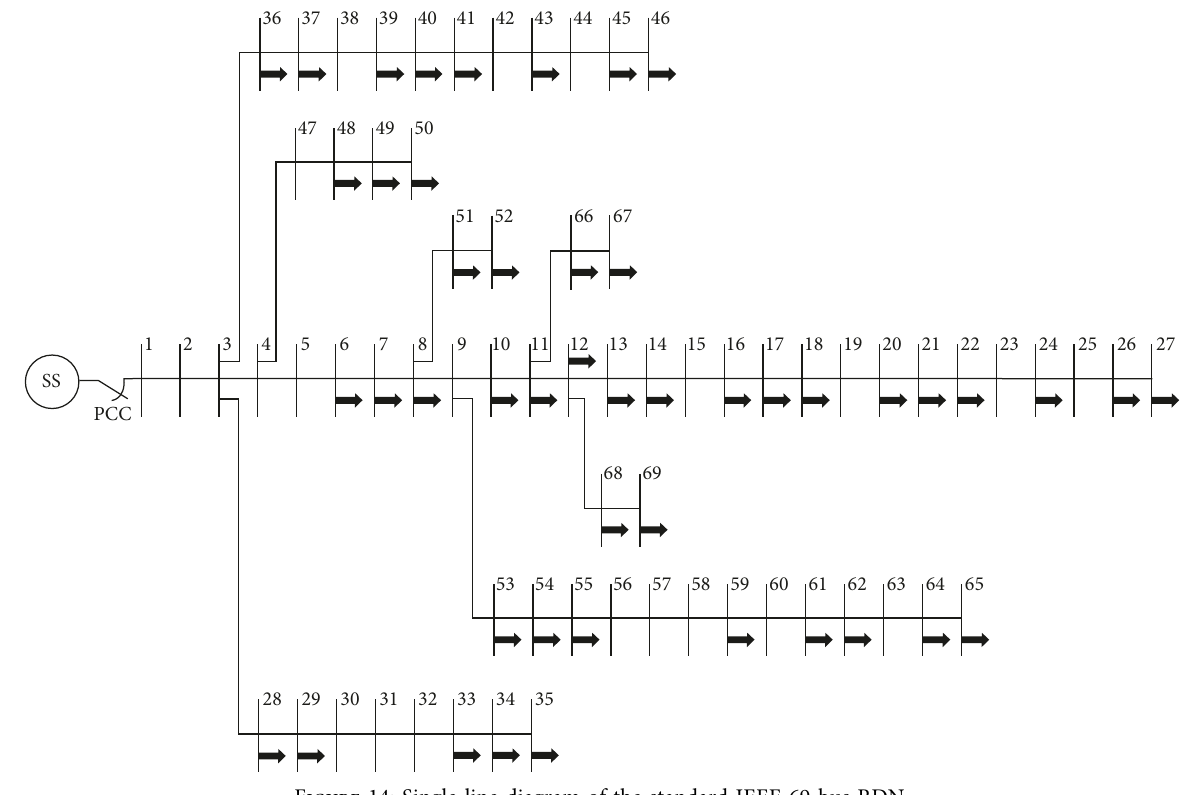
Figure 14: Single-line diagram of the standard IEEE 69-bus RDN.